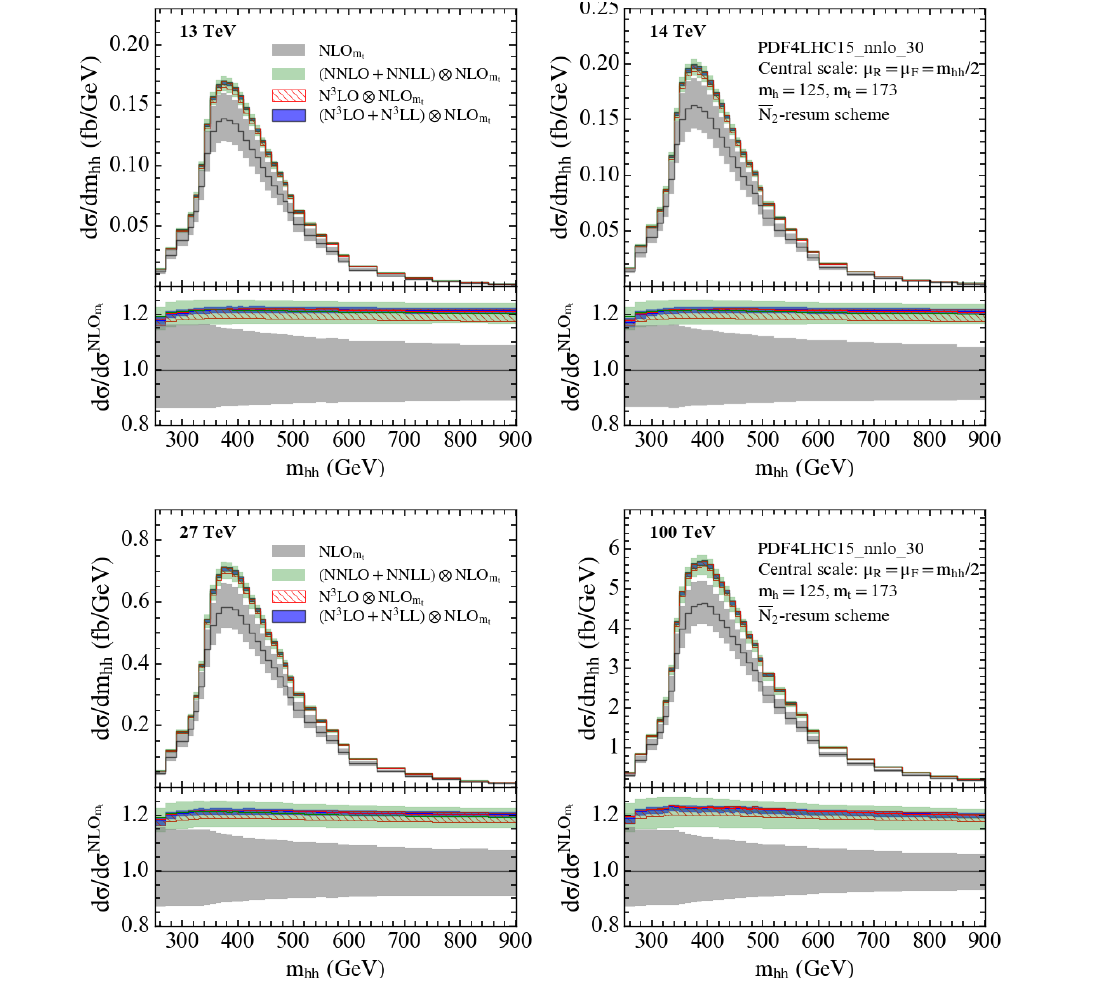
Figure 6 . The invariant mass m hh distributions with finite top quark mass corrections at four center- √ of-mass energies s = 13 , 14 , 27 , 100 TeV. The error bands are from the 7-point scale variations. The grey, green, red hatched and blue bands correspond to the NLO , (NNLO + NNLL) ⊗ NLO , m t m t N 3 LO ⊗ NLO and (N 3 LO + N 3 LL) ⊗ NLO predictions, respectively. The bottom panel shows m t m t the ratios to the NLO m t